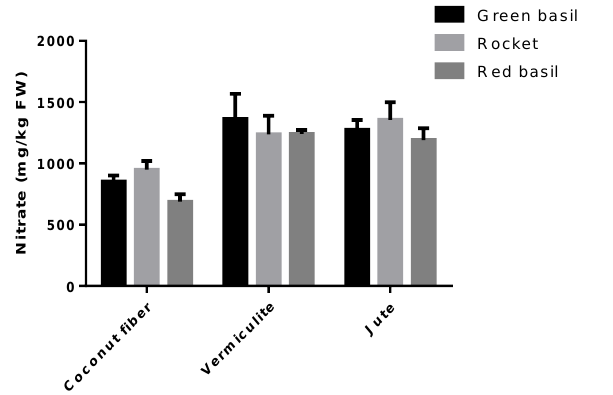
Figure 5. Nitrate concentration of green basil, rocket, and red basil microgreens grown on three different substrates. Values, subjected to two-way ANOVA, are means ± SE (n = 6).